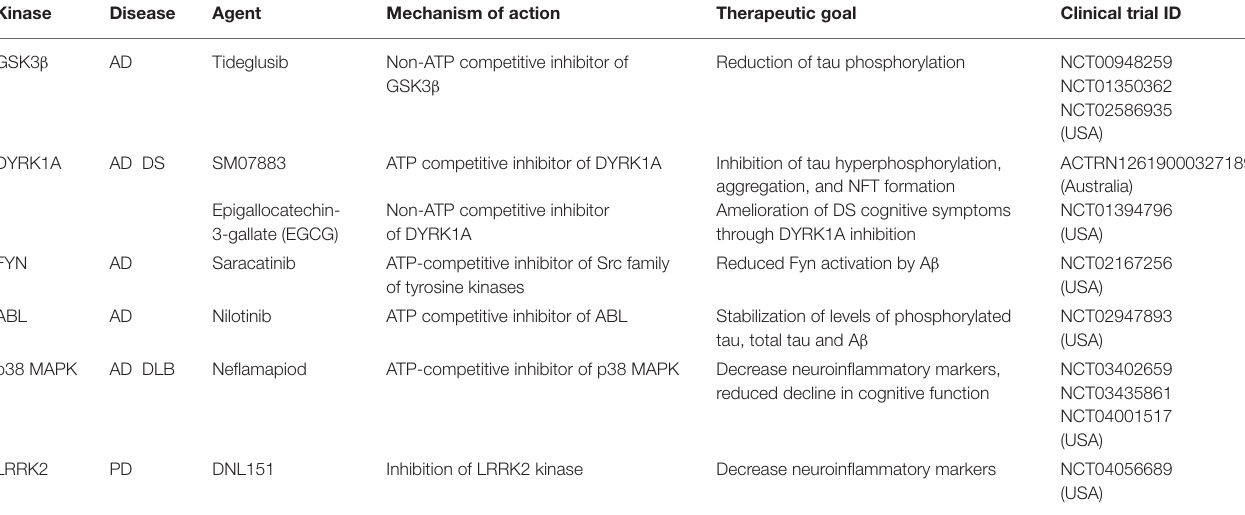
TABLE 2 | Kinase inhibitors in clinical trials for the treatment of neurological disorders.